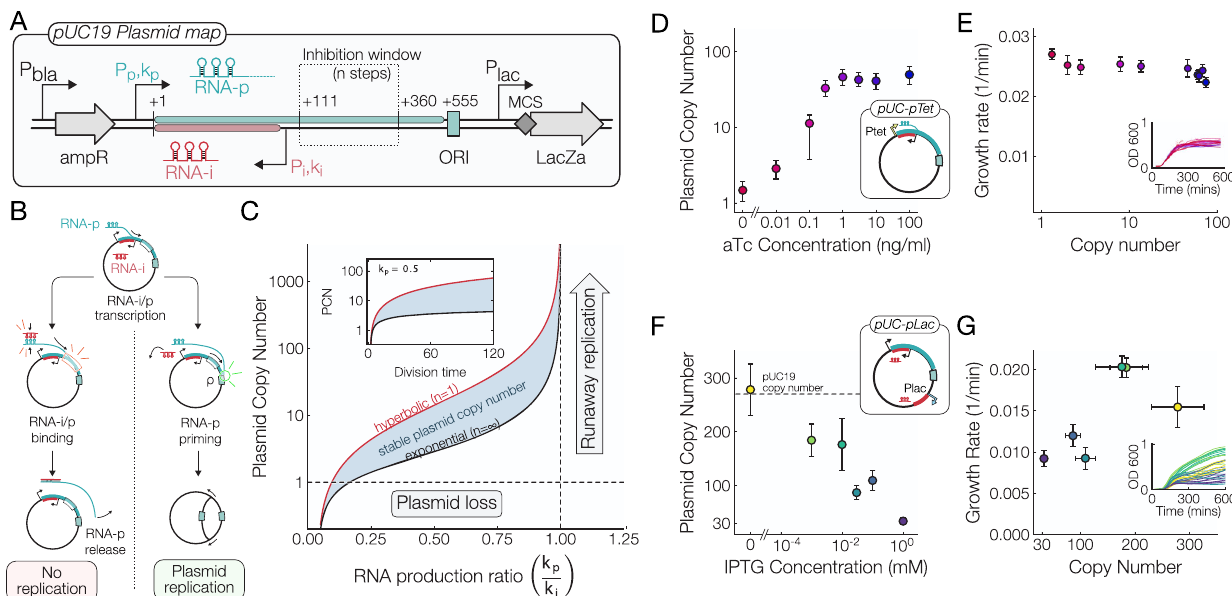
Fig. 1 Replication of ColE1 origin plasmids. A Map of the pUC19 plasmid. The origin of replication consists of a 555 bp region containing the priming RNA (RNA-p), the inhibitory RNA (RNA-i), the inhibition window, and the site of replication initiation (ORI). B Diagram of the steps leading to ColE1 replication. In the ColE1 Origin, reversible binding of the inhibitory RNA-i to RNA-p exercises control over the copy number by inhibiting replication (left branch). Production of RNA-p transcript triggers plasmid replication through the hybridization of RNA-p with the ORI (right branch). C Predicted plasmid copy number for hyperbolic (upper) and exponential (lower) initiation models 28 plotted as a function of RNA-p transcription initiation rate. Inset shows the predicted dependence of plasmid copy number on host cell division time. Model parameters: ϵ = 0.545 min, ρ = 0.65, r = 0.01 min, k i = 0.95 min. D Plasmid copy number measurements made by digital droplet PCR of the aTc-inducible pUC-pTet plasmid at increasing aTc concentrations; n = 3, error bars derived from Poisson distribution of ddPCR counts. E Growth rates of cells hosting the pUC-pTet plasmid at increasing plasmid copy numbers. We see a marginal effect of plasmid copy number on cellular growth rates, inset shows individual growth curves colored by aTc concentration. Data points are means across n = 6 biological replicates, error bars = std. dev. F Plasmid copy number measurements of a plasmid that contains an additional copy of the inhibitory RNA under the control of an IPTG-inducible promoter; n = 3, error bars derived from Poisson distribution of ddPCR counts. G Growth rate vs plasmid copy number of the IPTG-inducible plasmid shows a strong metabolic burden at high levels of RNA-i expression. Data points are means across n = 6 biological replicates, error bars = std.